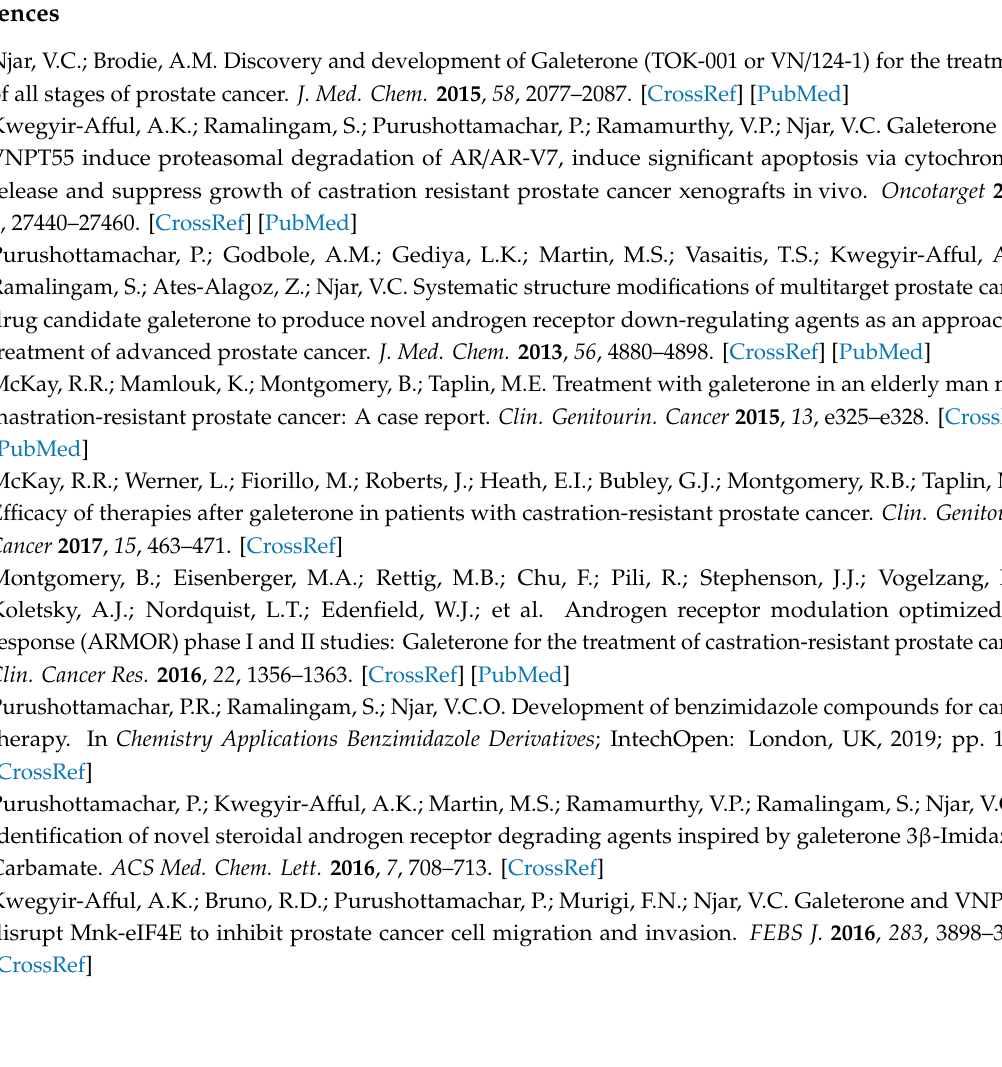
Figure S3: NGGAs modulate EMT markers; Figure S4: VNPP414 and VNPP433-3 β inhibit DU-145 cells